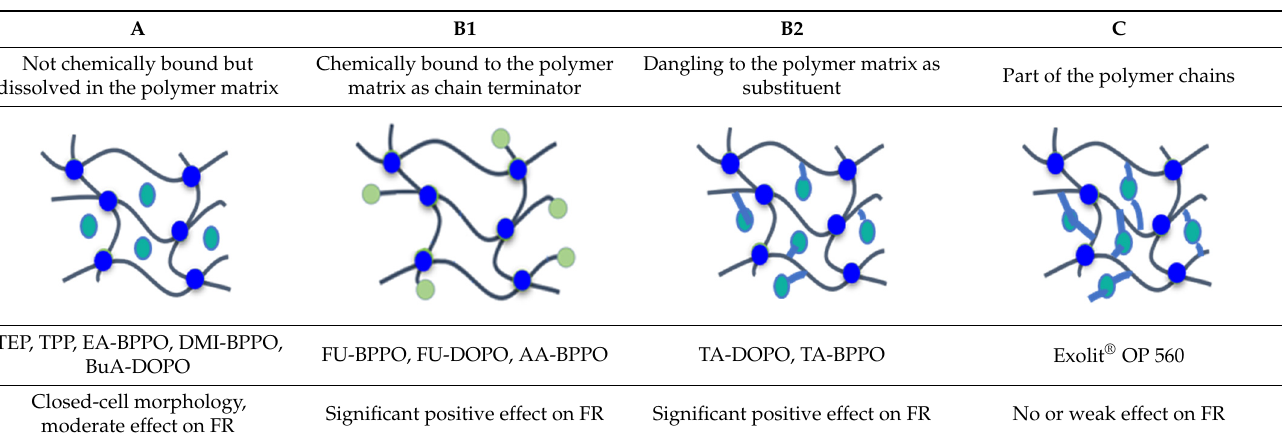
Table 10. Schematic representation of the P-containing FRs incorporated in different manners into rigid PIR foams, typical examples studied, and summarized result.